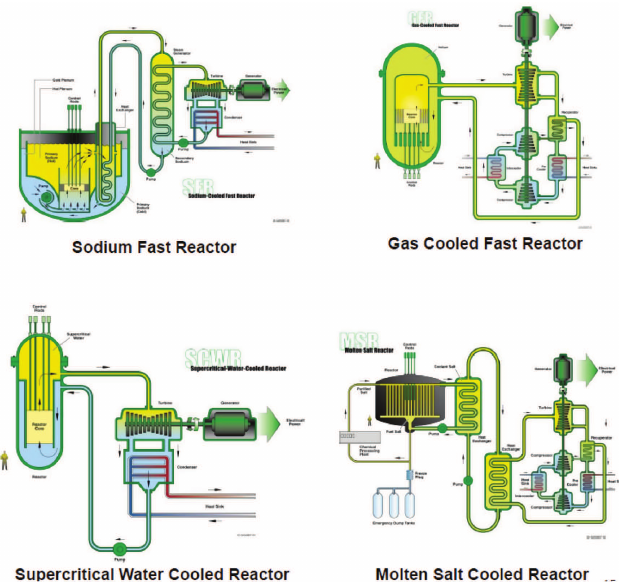
Fig. 1. Four Generation-IV systems supported by the consid- ered EU